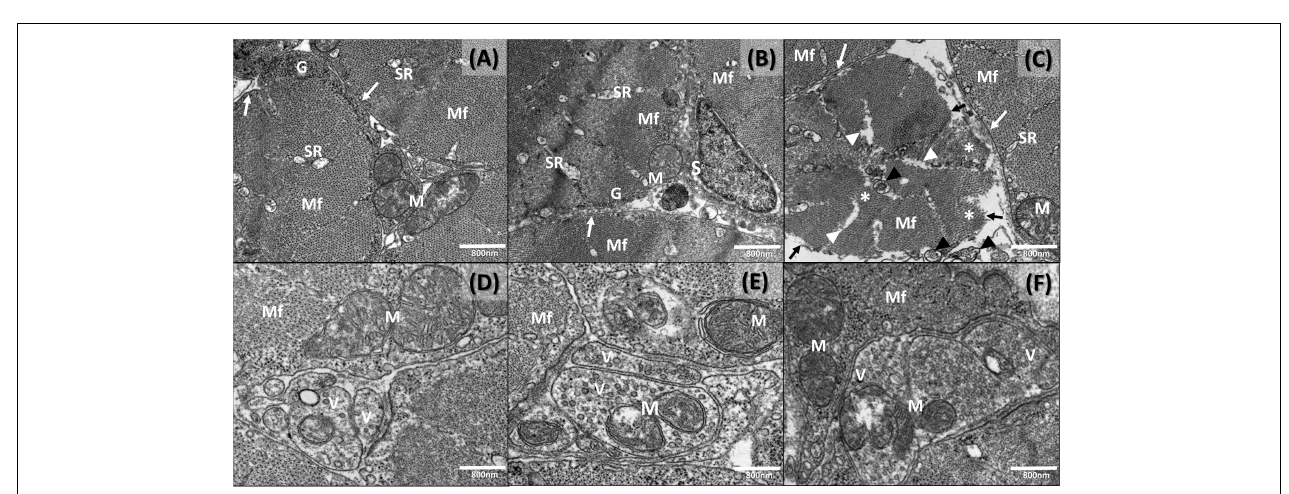
FIGURE 5 | Transmission electron micrographs of newborn seahorse muscle (longitudinal sections) from groups M, AM and A. (A) Group AM: normal sarcomere with light isotrope band (I); Z line; dark anisotrope band (A) , central H-zones and in the middle M lines (arrow); triad located at the Z line level. (B) Group A: myofibrils with a slight disarrangement. (C) Group AM: higher magnification. Note tubule T between two terminal cisternae close to each other just forming the longitudinal connection. (D) Group M: a regular zigzag configuration of the Z line of the sarcomere. (E) Group A: interruption of Z line (circled). (F) Higher magnification interruption of above circled Z line. SR, sarcoplasmatic reticule; G, glycogen; Tc, terminal cisternae; T, Tubule T; S, satellite cells.